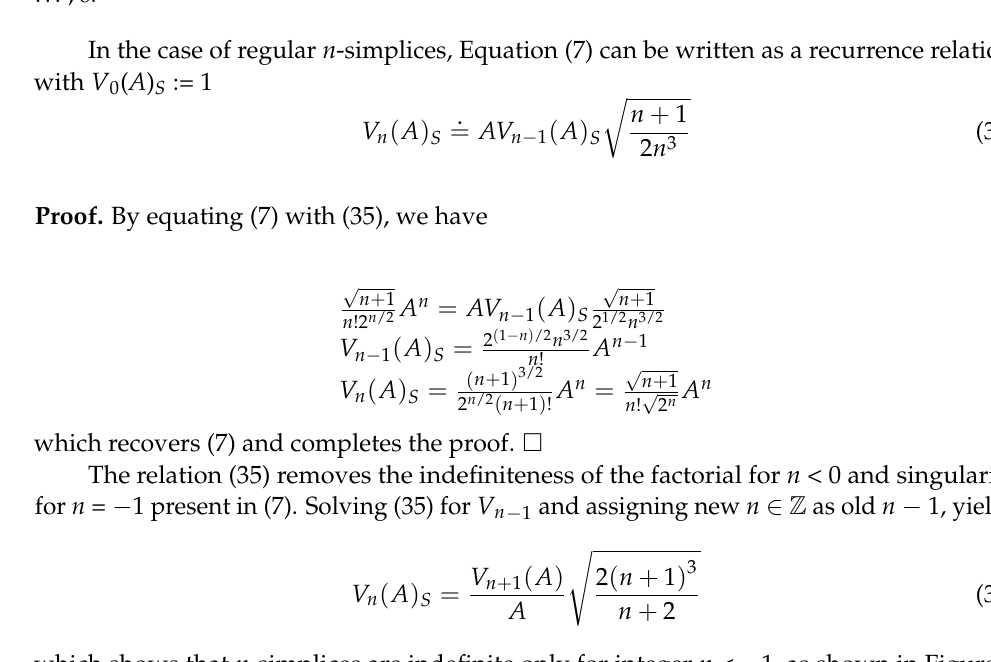
Figure 4. Graphs of volumes ( V ) and surface areas ( S ) of n -balls of unit diameter for n = −10, −9, …,8.